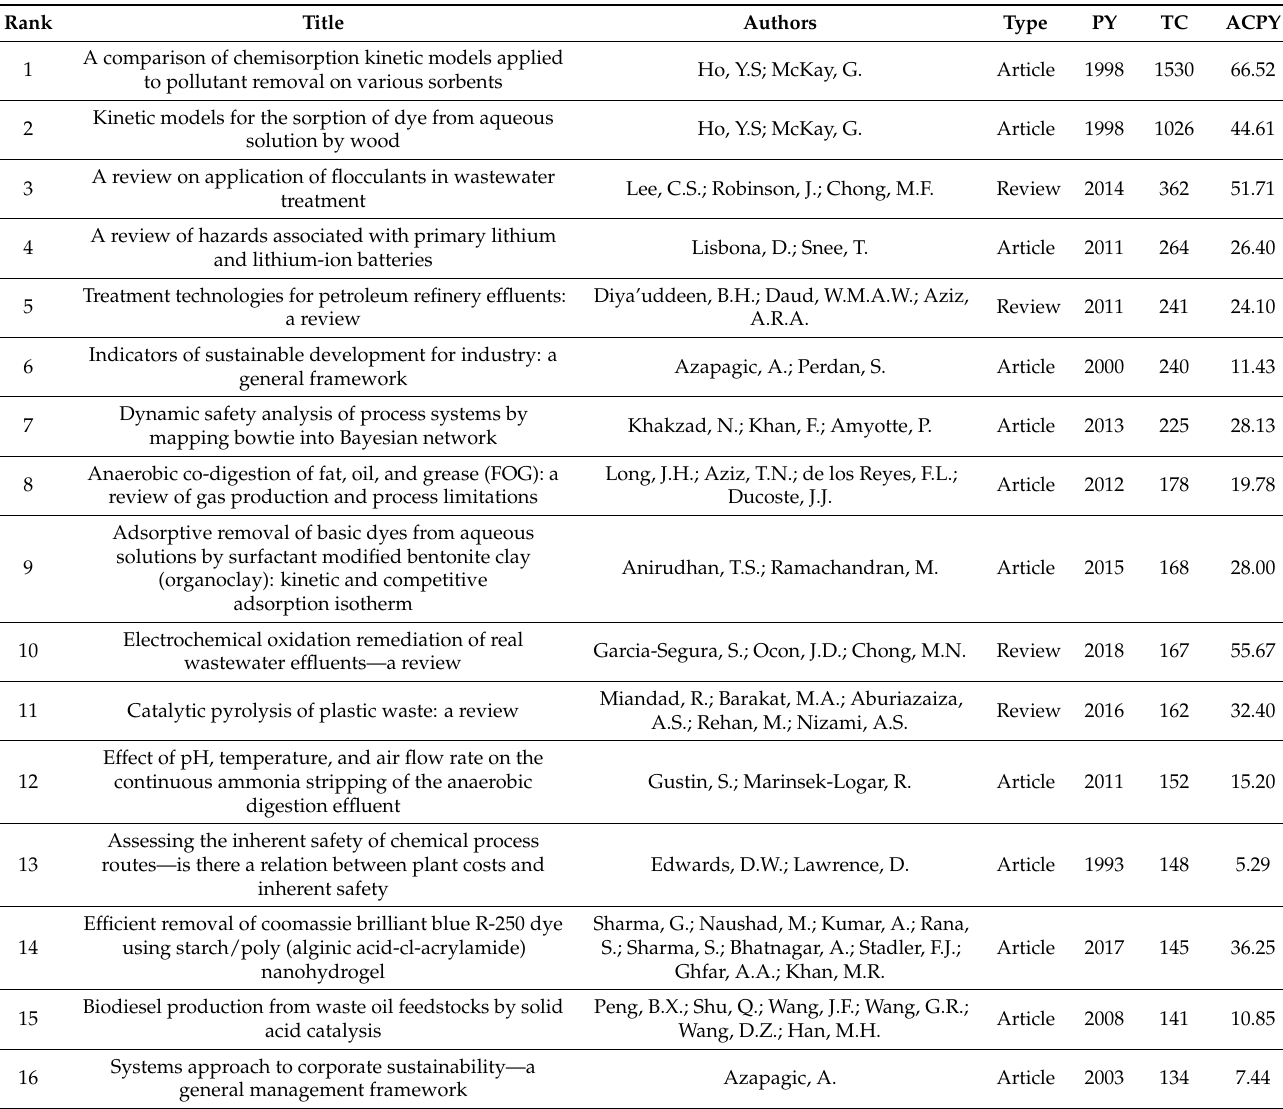
Table 5. Top 25 most cited papers published in PSEP during 1990–2020 (papers were ranked with the total number of